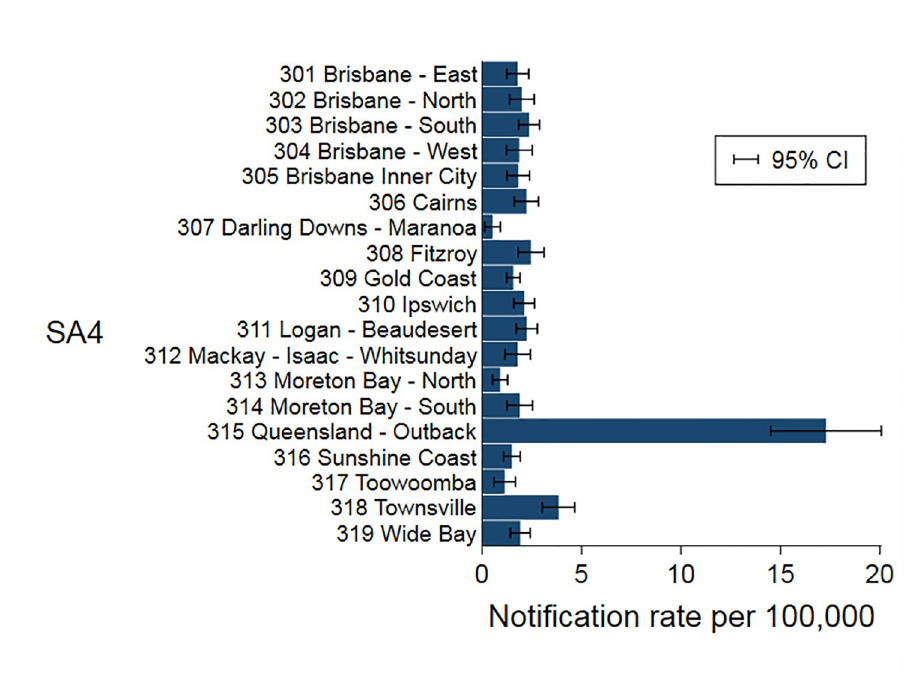
Fig 5. Adjusted notification rates of iNTS disease in Queensland by Statistical Area level 4, 2007–2016.